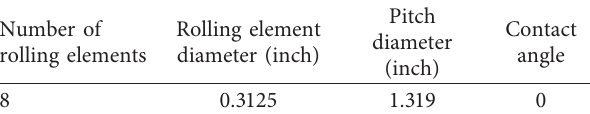
Figure 6: The trend of SNR with (a) step size and (b) underdamping factor. Table 1: Information of the tested bearings.